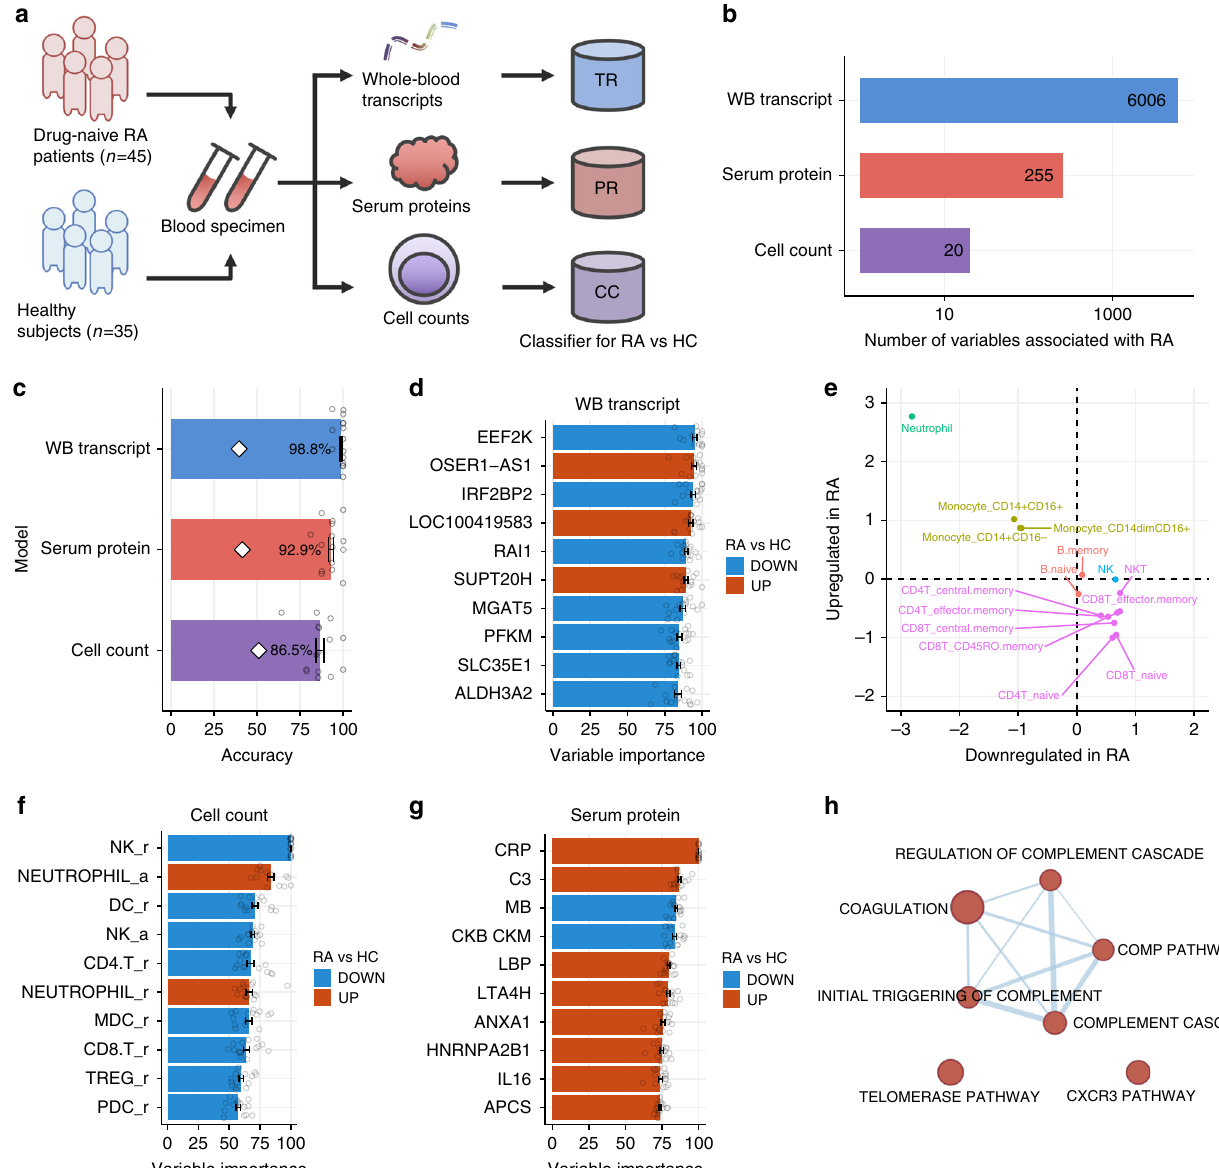
Fig. 1 Identi fi cation of molecular signatures associated with drug-naive patients with RA. a Study design. TR, PR, and CC represent the transcript-based model, the protein-based model, and the cell-count-based model, respectively. b The number of variables associated with drug-naive patients with RA. A linear regression model was used to compare the levels of variables between RA and HC accounting for age. For the transcripts, the RNA integrity number was also included in the model. The false discovery rate was controlled at 5%. c Cross-validation performances of RA diagnostic models. PLSR was employed to build predictive models. Fifteen PLSR models for each data type were generated using 15 different portions of samples as training data. The bar plot represents the average prediction accuracies against the testing data with the standard deviation. White diamonds indicate the expected accuracy of the null models estimated by 1000 sample permutations. d The top ten important transcripts for discriminating patients with RA and HC. Error bars represent the variabilities of the contribution to the model prediction that originated from the model ensemble. e Expression pro fi les of important transcripts across 15 immune cells. Meta-expression features of important upregulated or downregulated transcripts in RA were calculated separately using the ssGSEA method and standardized across immune cells. f The top ten important cell types for discriminating between patients with RA and HC. A suf fi x of “ r ” indicates that the cell counts were normalized to the total number of white blood cells, and a suf fi x of “ a ” indicates absolute cell counts. g The top ten important serum proteins for discriminating patients with RA and HC. Error bars represent the variabilities of the contribution to the model prediction that originated from the model ensemble. h Biological enrichment of in fl uential serum proteins in the model. Serum proteins with a variable importance greater 50 were used for enrichment analysis using hypergeometric test. The biological concepts enriched at the signi fi cance level of p value <0.05 and FDR <0.05 are displayed. Red nodes represent biological concepts enriched with proteins that are upregulated in RA. Nodes are connected if there are shared genes in two biological pathways. The error bars represent standard